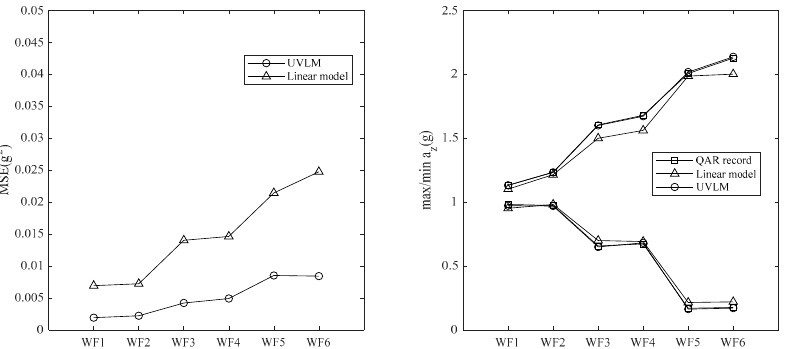
Figure 9. Acceleration response comparison of linear model and UVLM.